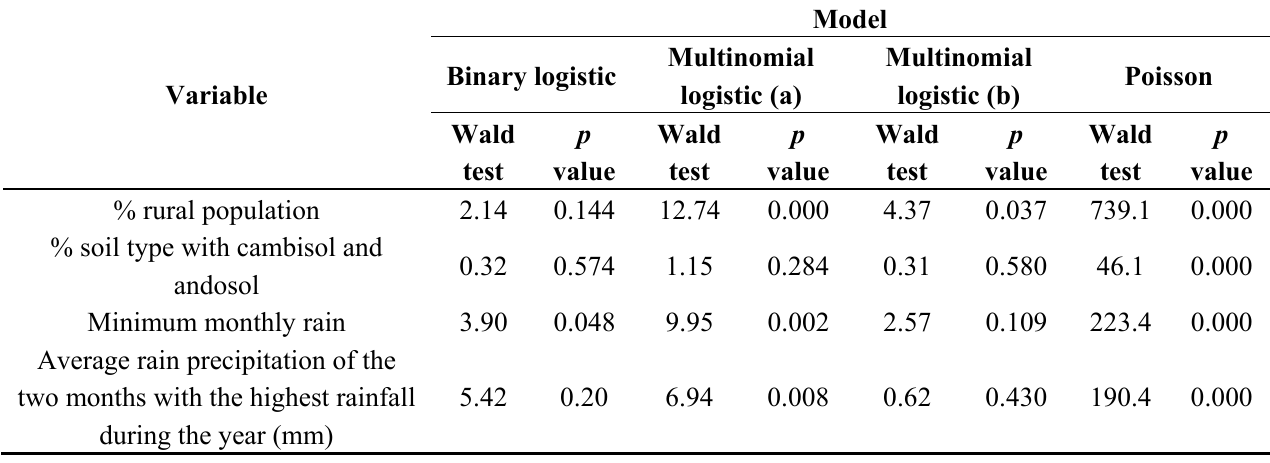
Table 7. Comparisons of the different exploratory